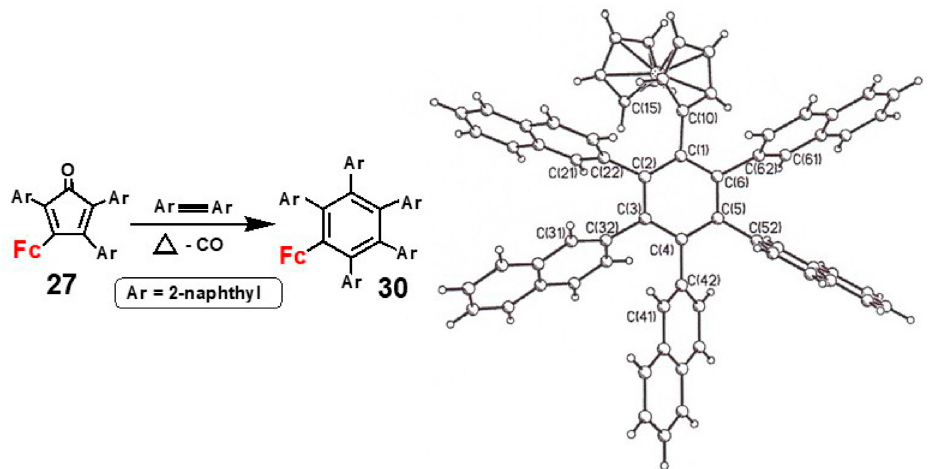
Figure 14. Synthesis and molecular structure of ferrocenyl-penta( β -naphthyl)benzene, 30 . Figure 14 is reprinted from the Canadian Journal of Chemistry; © Canadian Science Publishing or its licensors.